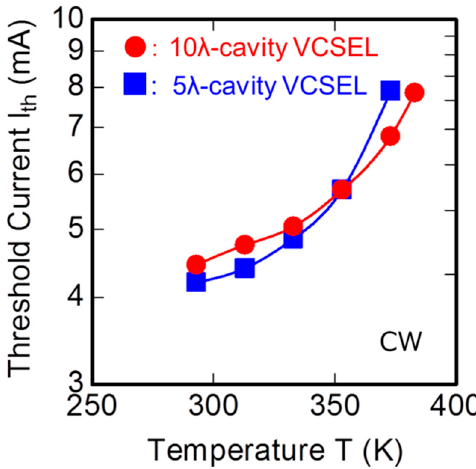
Figure 8. Temperature dependence of the threshold current under CW operation.